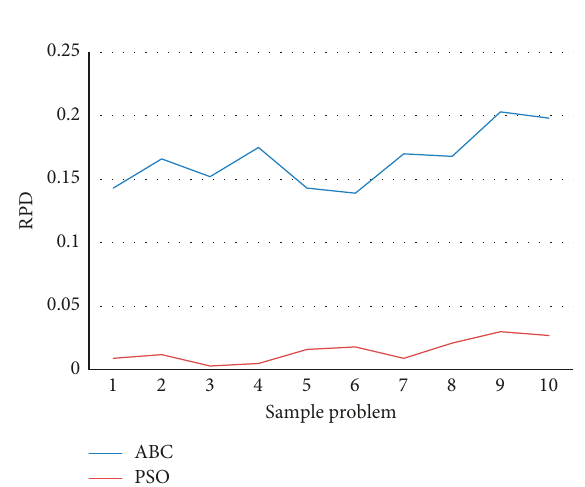
Figure 10: RPD diagram of the performance of the algorithms for each sample